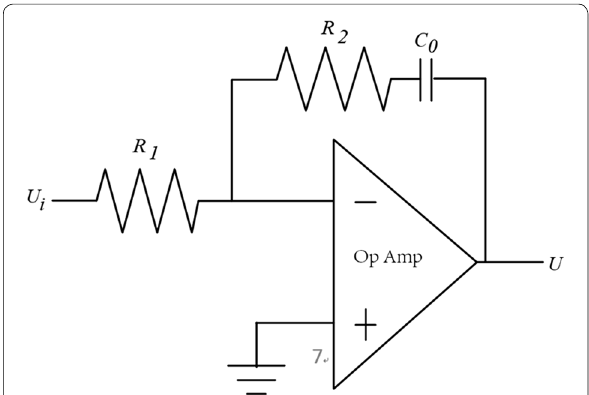
Figure 2 Proportional integral controller circuit